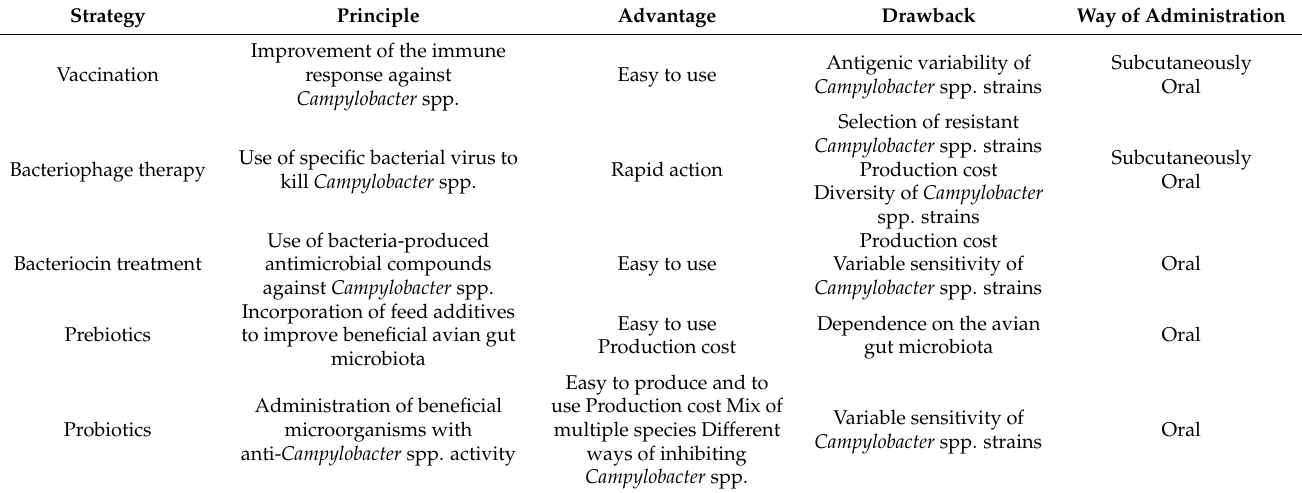
Table 3. Strategies in progress to control Campylobacter spp. at the farm level